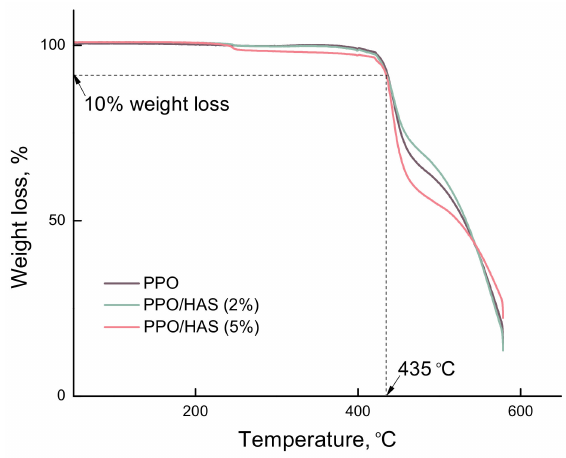
Figure 4. TG curves of PPO / HAS (0, 2, 5 wt%)